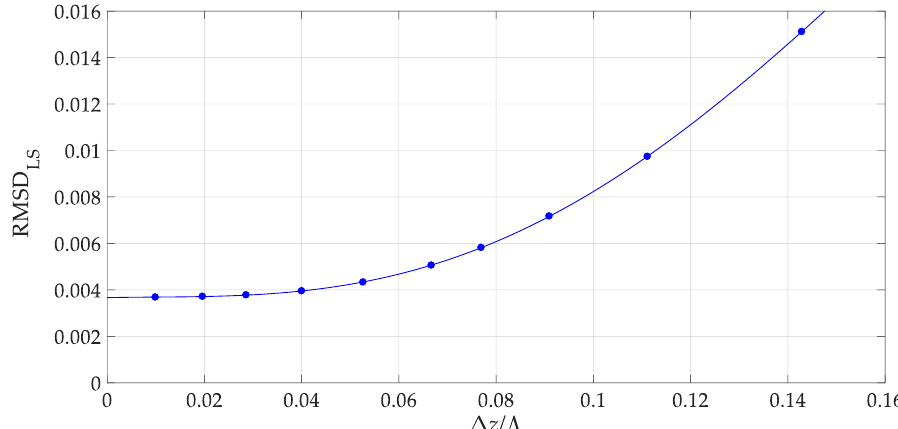
Figure 12. Values of the root-mean-square deviation (RMSD) of the phase-shifted FBG spectrum modeled using the LS method with odd number of partition points in the FBG period (blue dots) depending on the partition interval Δ z , and their approximation (blue solid line).